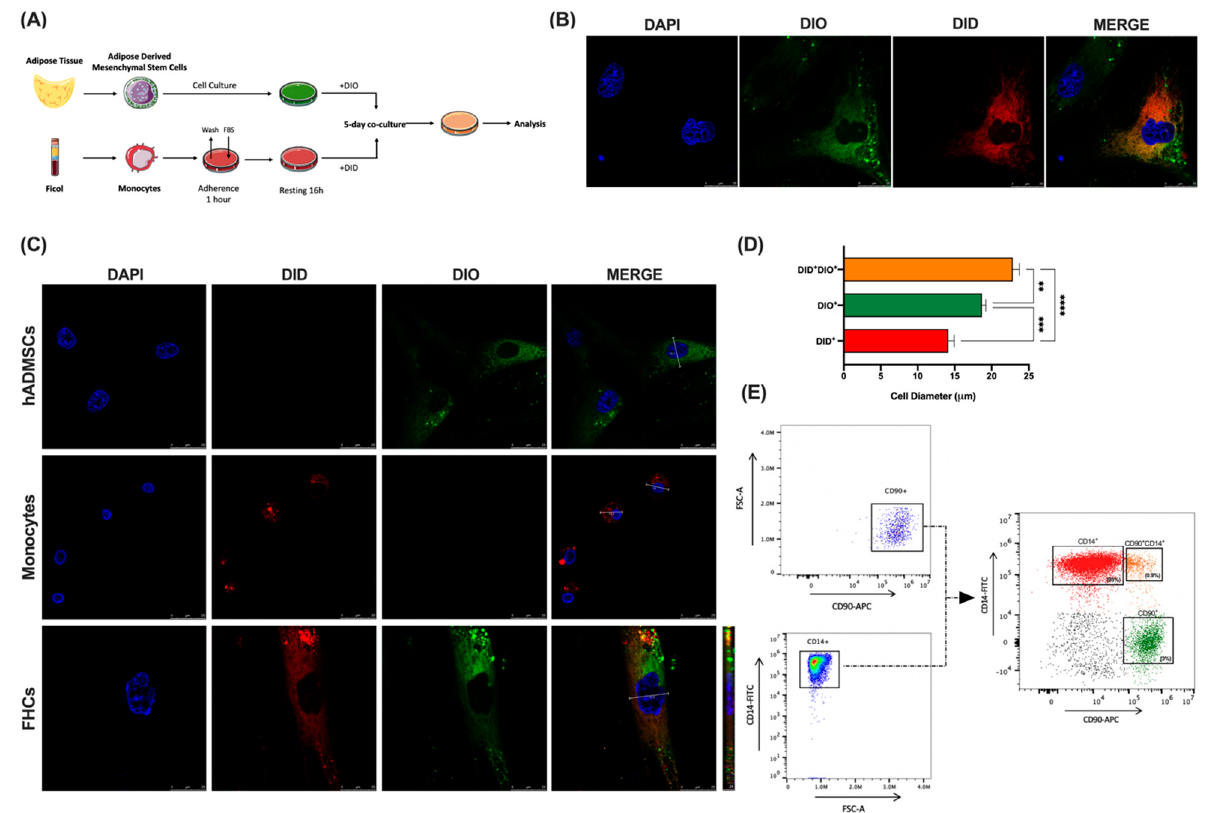
Figure 1. Human-adipose-derived mesenchymal stem cells fuse with human monocytes ex vivo. ( A ), Schematic representation of experimental co-culture conditions. ( B ), Representative confocal images at 63× magnification of co-cultured DIO stained hADMSCs (green) with DID stained monocytes (red) and DAPI for nuclei (blue) is shown. Merges show co-cultured cells DID + DIO + (tangerine). ( C ), Representative confocal images at 63× magnification of DIO stained hADMSCs (green), DID stained monocytes (red) and hybrid cells (FHCs) (tangerine) are shown. DAPI was used for nuclei labelling (blue). Diameter sizes are shown in merge panels. ( D ) , Diameter comparisons be- tween hADMSCs (green), monocytes (red), and FHCs (tangerine) are shown (n = 3). ( E ), Left panels, representative FACS analysis gating strategy illustrating CD90 + and CD14 + single staining’s. Right panel, dot plot after 5-day co-culture illustrates CD90 + hADMSCs (green), CD14 + human monocytes (red), and CD90 + CD14 + (FHCs, tangerine). **, p < 0.01; ***, p < 0.001; ****, p < 0.0001 in one-way ANOVA test with Tukey’s multiple comparison post-hoc test.